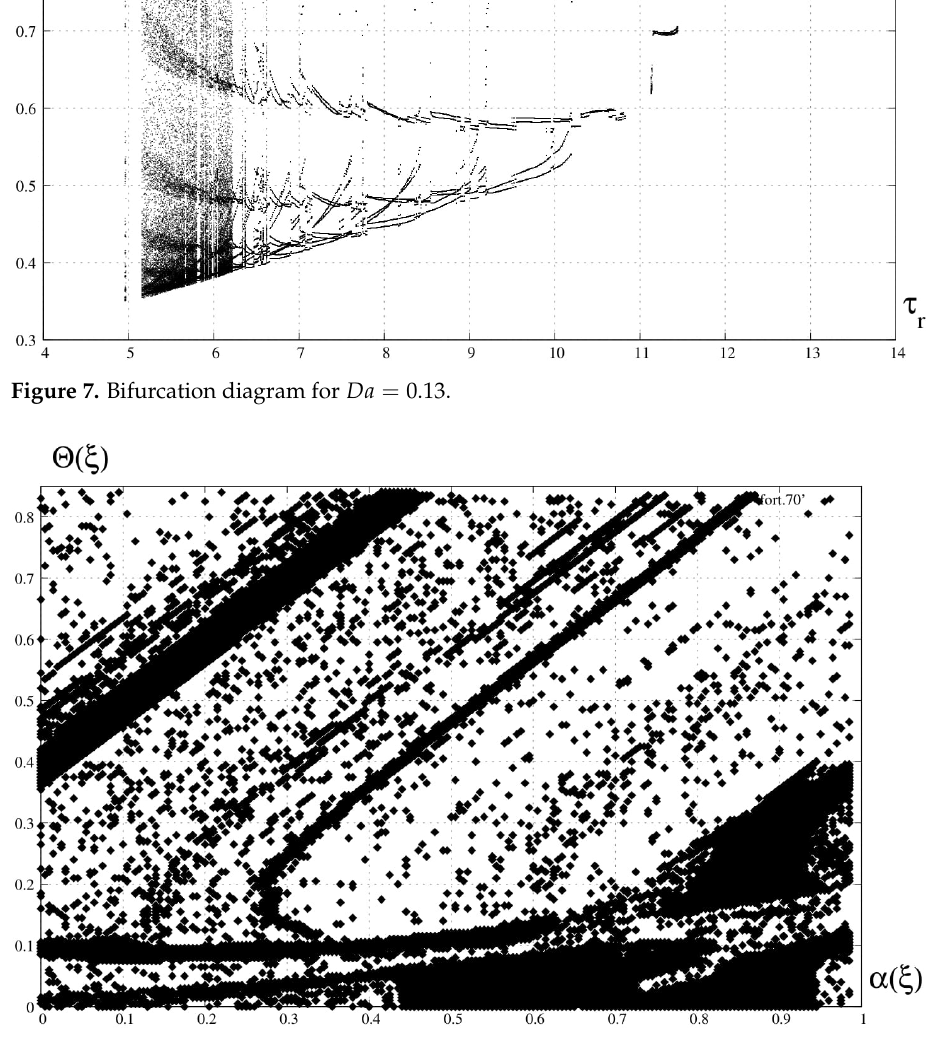
Figure 8. Map of periodic and chaotic